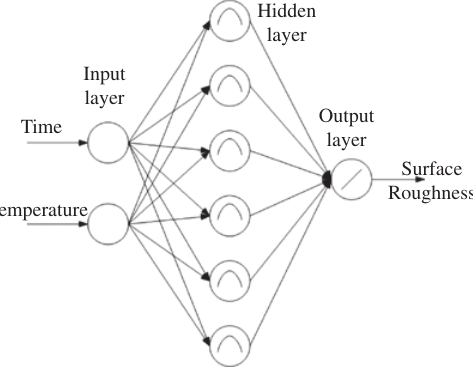
Figure 3 The structure of radial biased function network employed in this